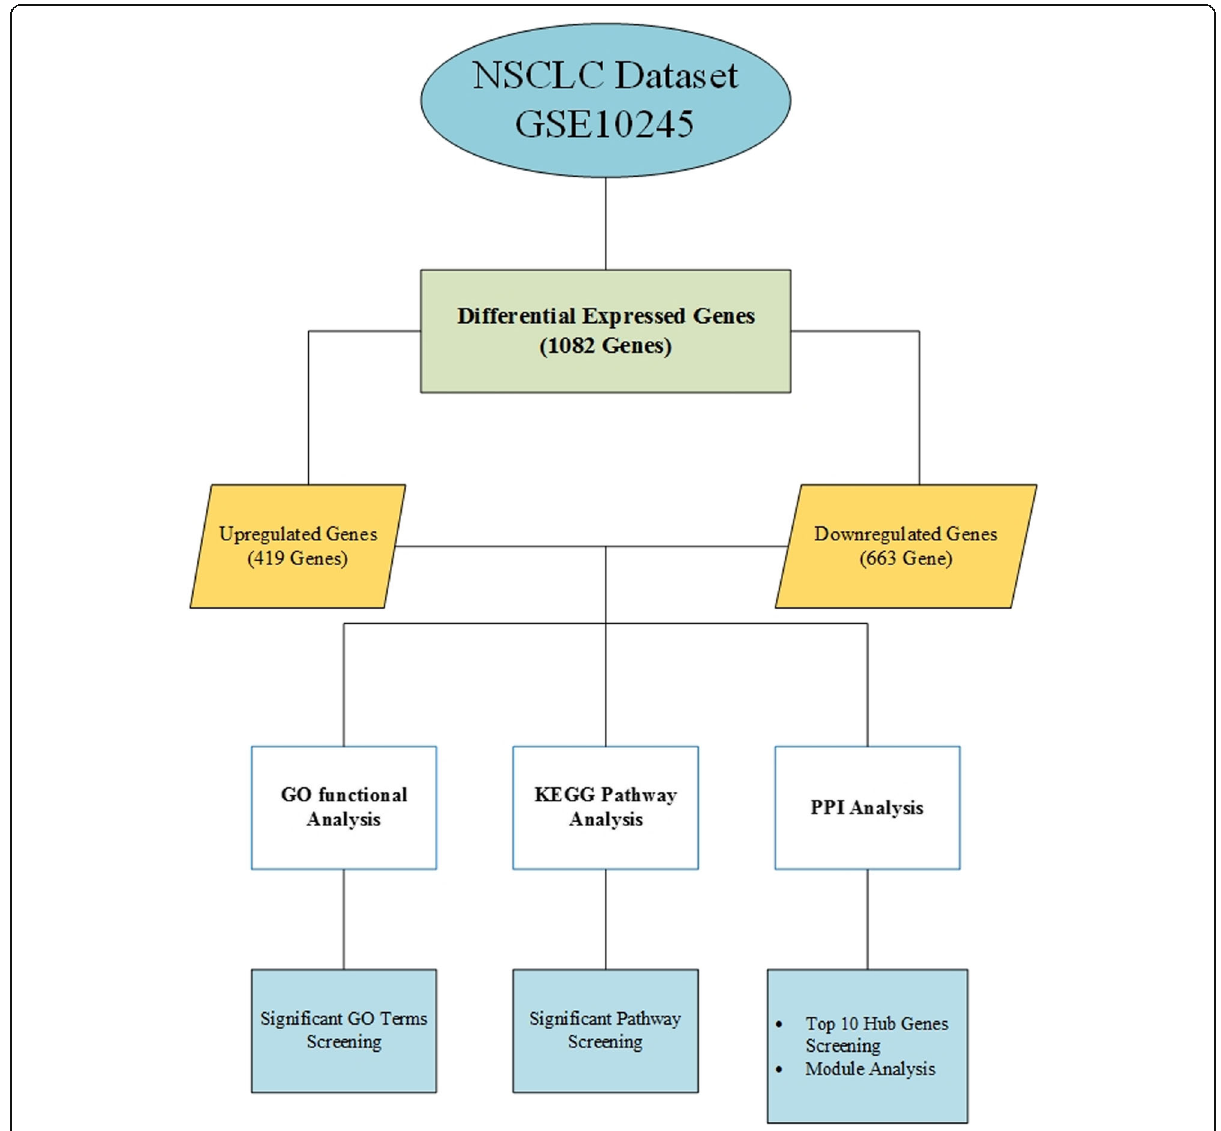
Fig. 1 Flow diagram of the analytical approach used in this